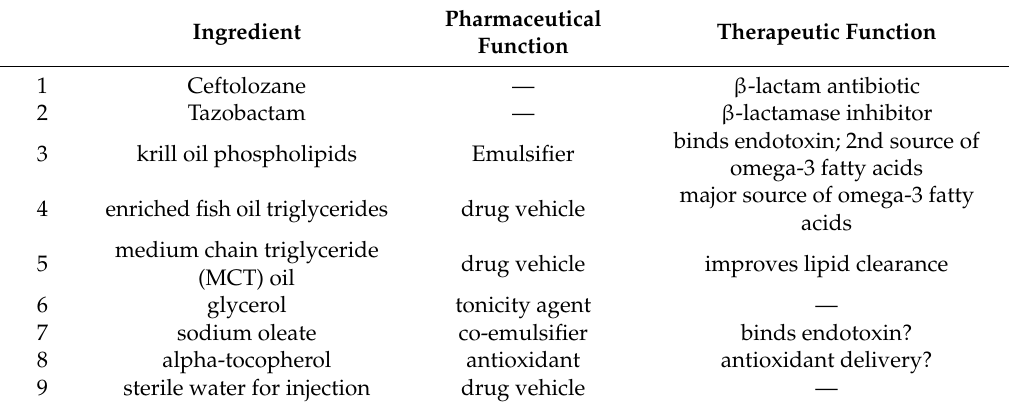
Table 1. Sample composition of an API regimen in the treatment of Gram-negative